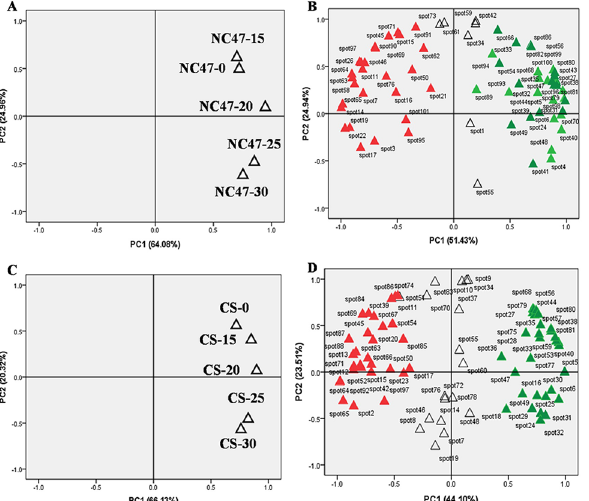
Fig 4. Principal components analysis (PCA) of the set of 101 DAP spots in NC47 and CS. (A) PCA of individual experimental samples in NC47. (B) PCA of 69 differentially accumulated protein spots in NC47. (C) PCA of individual experimental samples in CS. (D) PCA of 77 differentially accumulated protein spots in CS. Red spots indicate an upregulated protein; green spots indicate a downregulated protein. CS-0, CS-15, CS- 20, CS-25 and CS-30 represent the 0, 15%, 20%, 25% and 30%, respectively, of the PEG6000 concentration treatment in CS. NC47-0, NC47-15, NC47-20, NC47-25 and NC47-30 represent the 0, 15%, 20%, 25% and 30%, respectively, of the PEG6000 concentration treatment in